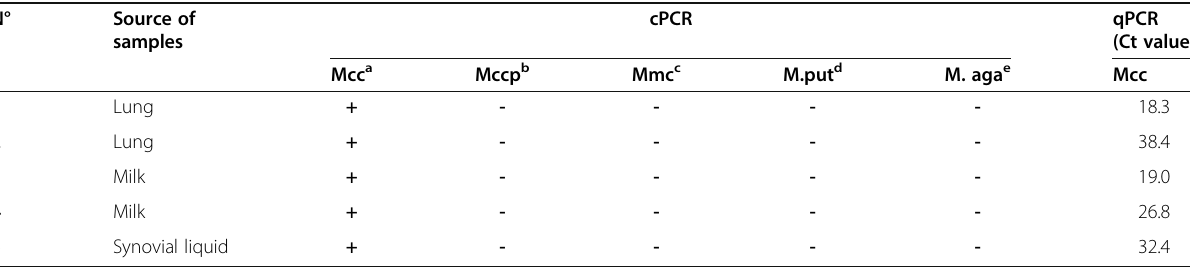
Table 1 PCR-based identification of Mycoplasma species from samples of goats N° Source of